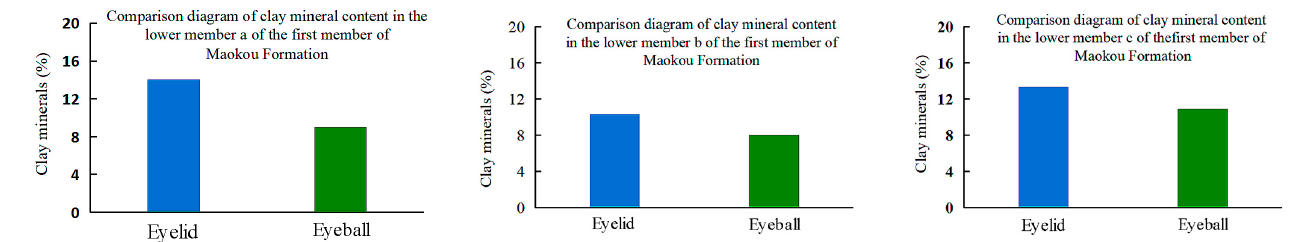
Figure 6. Comparison of clay mineral content in the eyelid and eyeball of the first member of Maokou Formation.